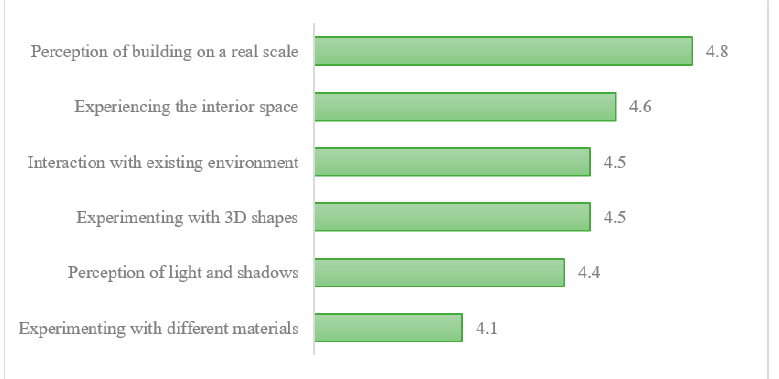
Figure 6. The IVR items that most influenced the design, according to students; on a Likert scale of 0–5.